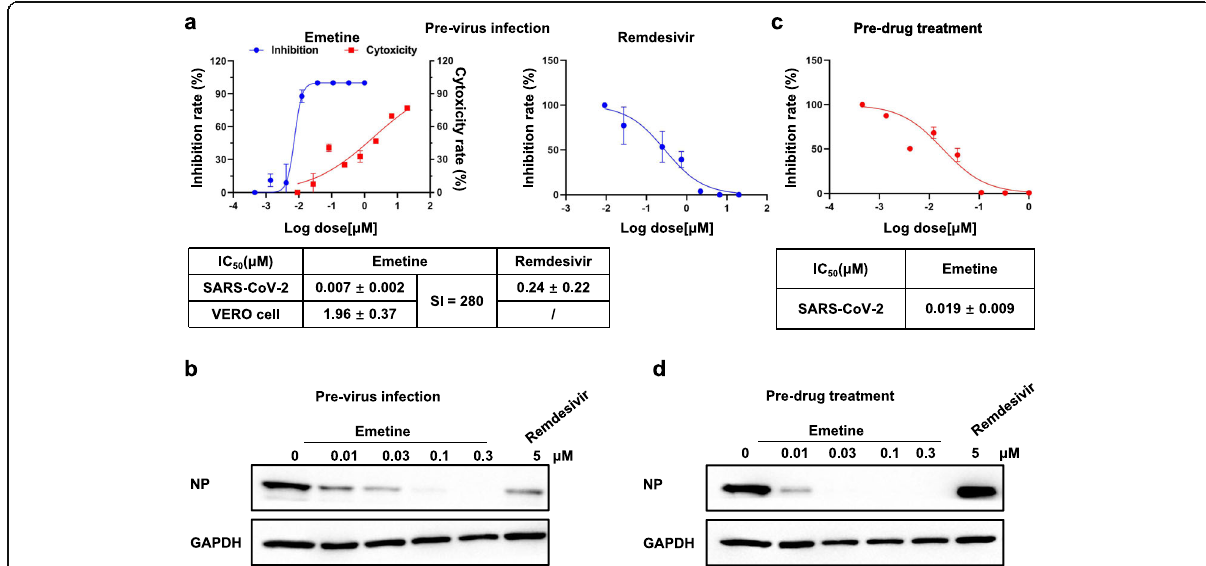
Fig. 1 Antiviral effect of Emetine in Vero cells. a Antiviral replication effect of Emetine in Vero cells (EC 50 ). Cells were pretreated with virus (30 TCID50) in 96 well plates for 1.5 h then virus was washed away and increasing concentrations of drugs (Emetine, Remdesivir) were added and remained for 48 h before qRT-PCR analysis. Cytotoxicity of Emetine against Vero cells were tested with CCK8 assay. b Western blot analysis of nucleocapsid level in Vero cells for anti-replication effect. Cells were infected by virus (30 TCID 50) in 6-well plate for 1.5 h then washed way and increasing concentrations of drugs were added and remained for 24 h until analysis. c Antiviral entry effect of Emetine in Vero cells. Cells in the 96-well plate were pretreated with increasing concentrations of Emetine for 3.5 h before virus (30 TCID50) was added and followed by co- incubation for 1.5 h. Then both the drug and virus were washed away and cells remained in the maintenance medium for 24 h before PCR analysis. d Western-blot analysis of nucleocapsid level in Vero cells for anti-entry effect. Cells were pretreated with increasing concentrations of drugs for 3.5 h in 6-well plate before virus (30 TCID50) was added and followed by co-incubation for 1.5 h. Then both the drug and virus were washed away and cells remained in the maintenance medium for 24 h before analysis